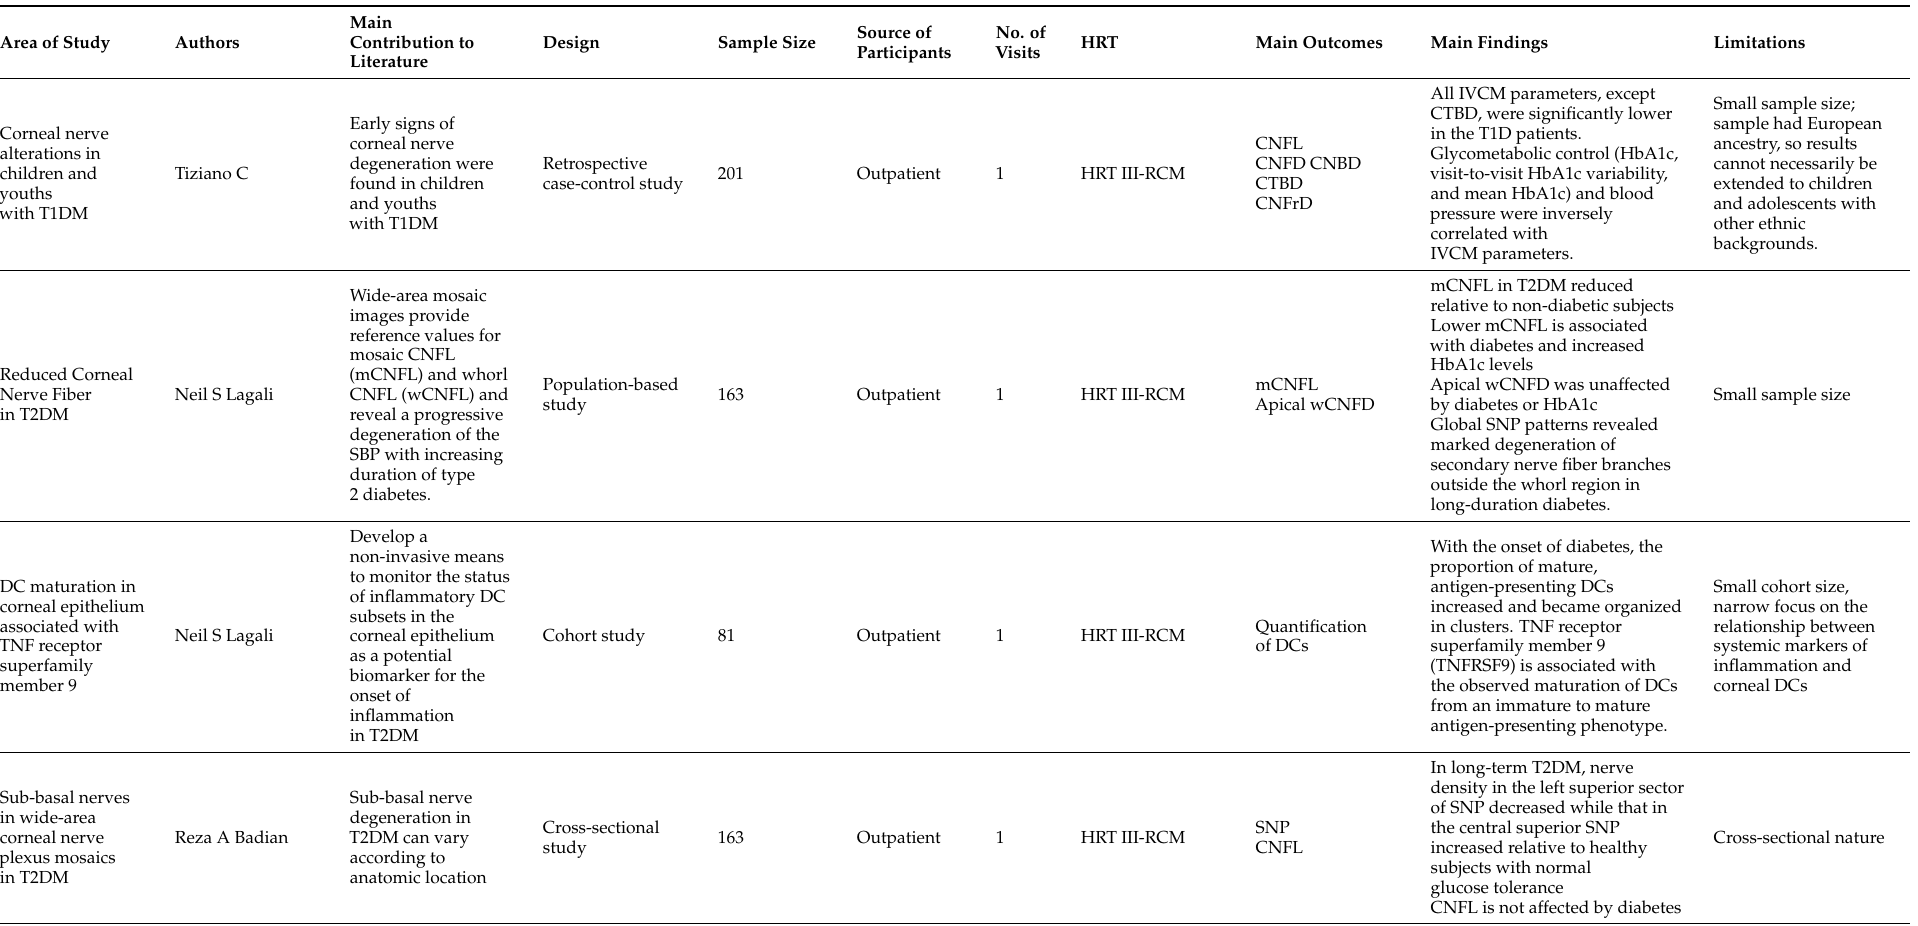
Table 4. Studies on Systemic Disease-related Dry